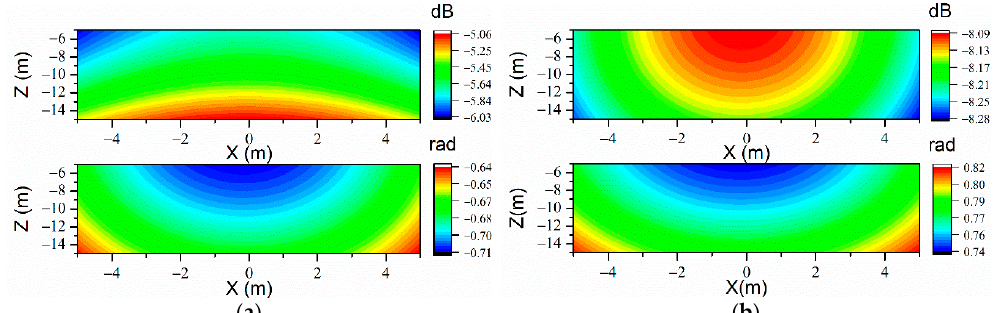
Figure 15. The sound prediction errors of VR-ESM on the prediction plane at the frequency of 71 Hz when 90 uniformly arranged measurement points are used. ( a ) Free field (upper: p E ; lower: ϕ E , L 1 = 66 ); ( b ) h U = 0.2 m (upper: p E ; lower: ϕ E , L 1 = 75 ).